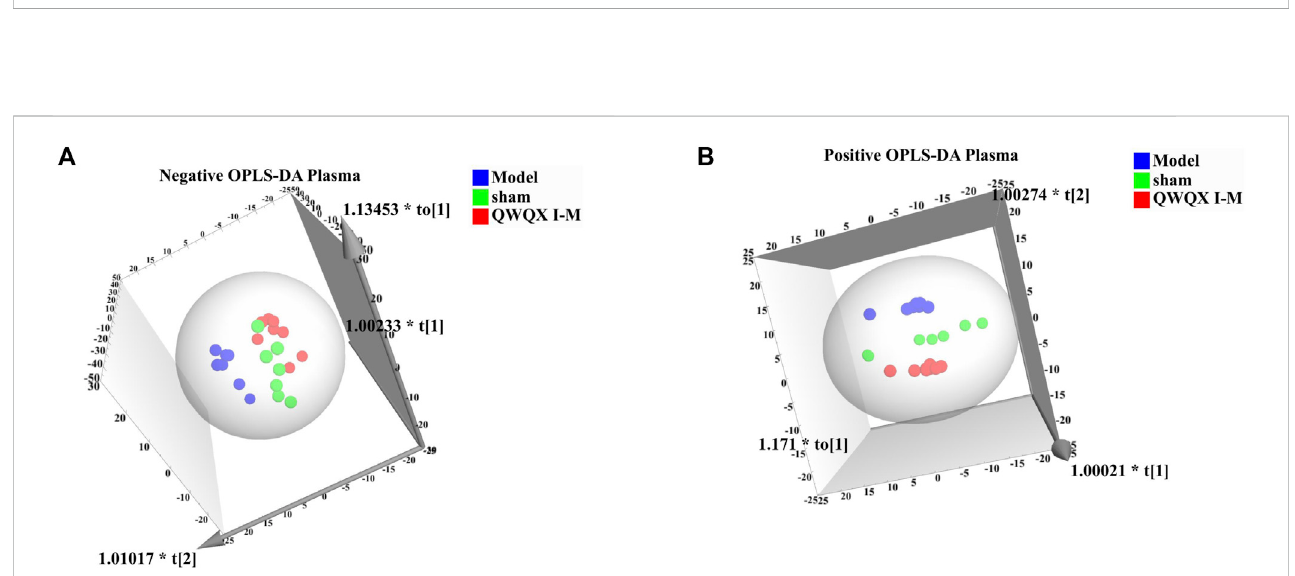
FIGURE 4 Plasma metabolomics OPLS-DA scores for each group of rats. (A) Negative mode of various rats. (B) Positive mode of various rats.